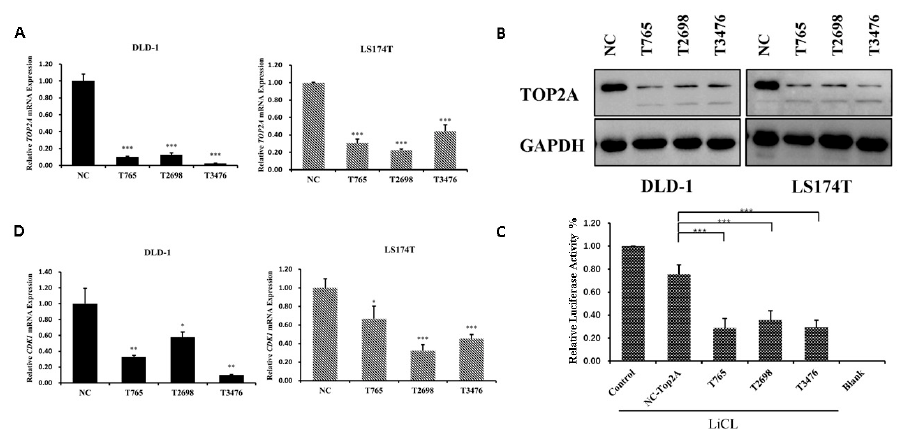
Figure 5. TOP2A regulates CDK1 expression and Wnt/ β -catenin signaling in CRC cells. ( A ) Knocking down of TOP2A by siRNAs. The mRNA levels of TOP2A were analyzed by real-time quantitative PCR (qRT-PCR). *** p < 0.001 vs. negative control. ( B ) Protein levels of TOP2A were analyzed by western blot. GAPDH was used as a loading control. ( C ) Depletion of TOP2A inhibited TOPFlash reporter activity induced by LiCl. “Control” indicates TOPFlash (800 ng/well) and Renilla vector (200 ng/well) plasmid transfection. “NC-TOP2A” indicates transfection of TOPFlash and Renilla vector plasmid as well as siRNA with low sequence homology and sequences unrelated to the target gene. “T765, T2698 and T3476” indicates transfection of TOPFlash and Renilla vector plasmid as well as siRNA with TOP2A. “Blank” indicates transfection of TOPFlash (800 ng/well) and Renilla vector (200 ng/well) plasmid without LiCl to activate Wnt signaling. *** p < 0.001 vs. NC-TOP2A. ( D ) qRT-PCR analysis of the effects of TOP2A siRNAs on the expression of CDK1 in DLD-1 and LS174T cells. * p < 0.05, ** p < 0.01, *** p < 0.001.